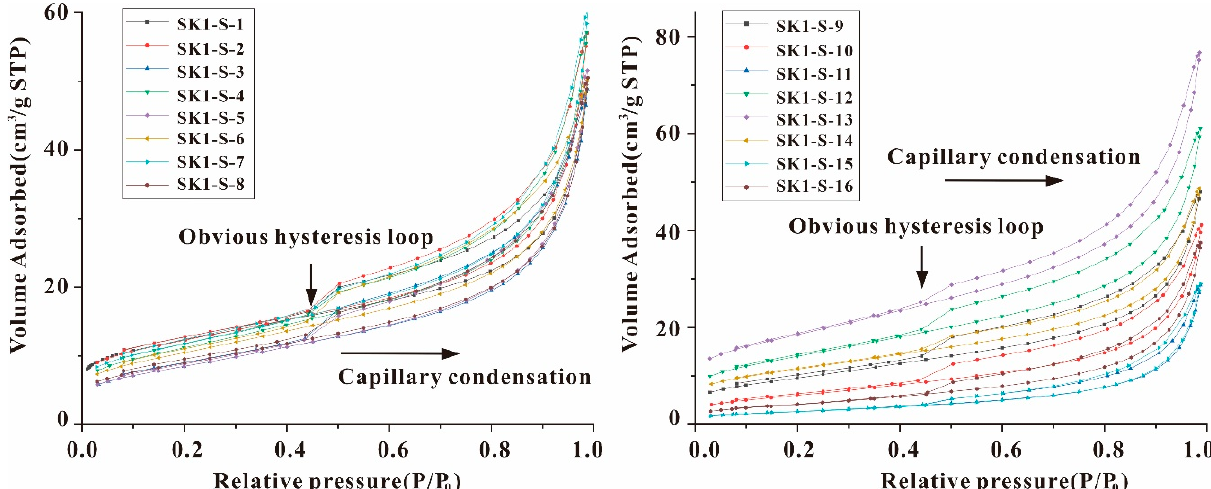
Figure 4. Nitrogen adsorption–desorption isotherms of K 2 n 1+2 samples.